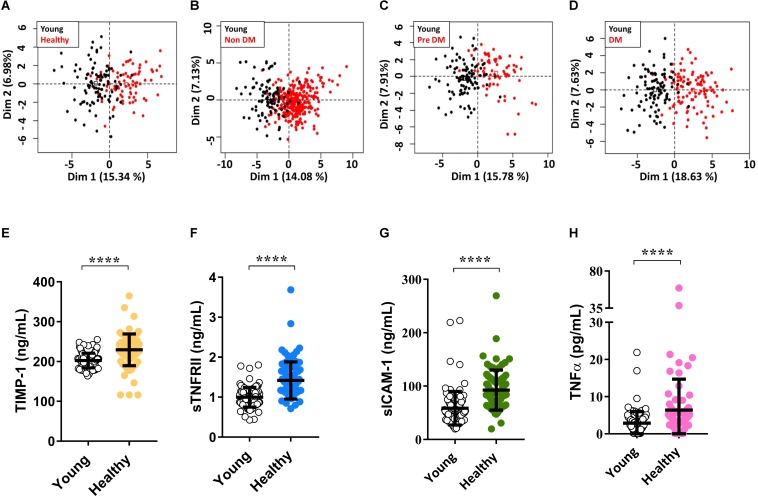
Higher level of the inflammatory molecules with aging. Unbiased analysis of all measured cytokines and chemokines using Principal Component Analysis (PCA) shows a clear separation between Young vs. Healthy (A), Young vs. Non-DM (B), Young vs. Pre DM (C), and Young vs. DM (D). Individual comparison of major cytokines shows a significant difference (P < 0.05) between Young vs. healthy for TIMP-1 (E), sTNFRII (F), sICAM-1 (G), and TNFα (H). P-values were calculated using non-parametric Mann–Whitney U-test and adjusted for Bonferroni multiple test correction (****P < 0.0001).